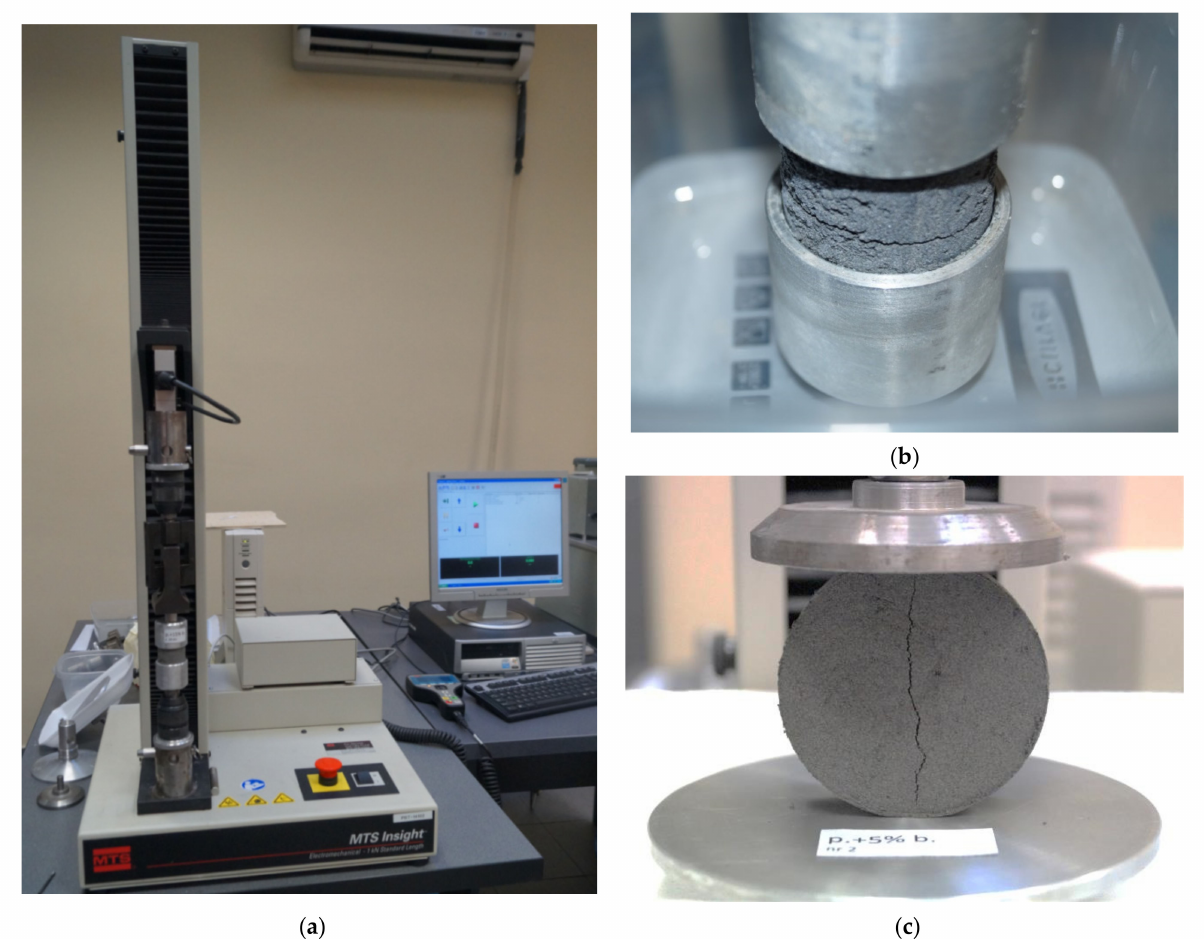
Figure 3. Laboratory testing of the tensile strength of the soils: ( a ) MTS Insight testing system; ( b ) the view of the sample during direct test; ( c ) the view of the sample during indirect